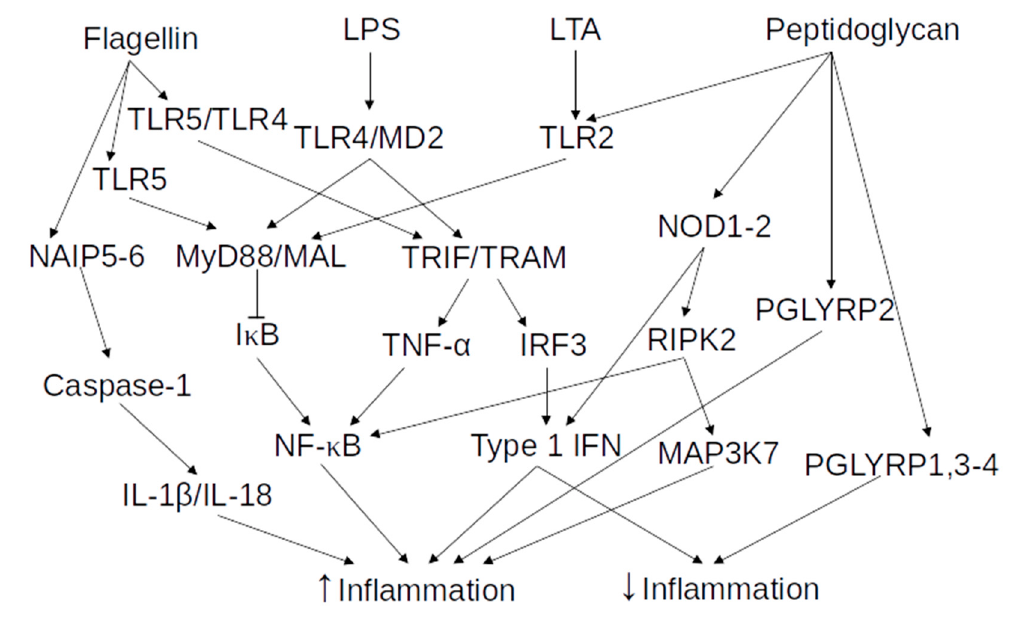
Figure 2. Overview of the selected MAMPs effects on the innate immune system. Arrow end—increase in activity or concentration. Blunt end—decrease in activity or concentration.